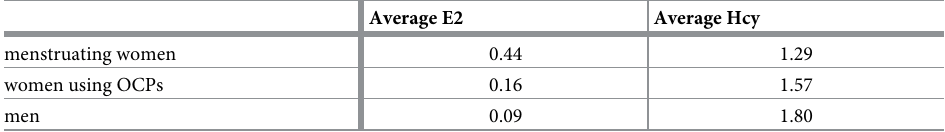
Table 1. Homocysteine and the contraceptive pill in the mathematical